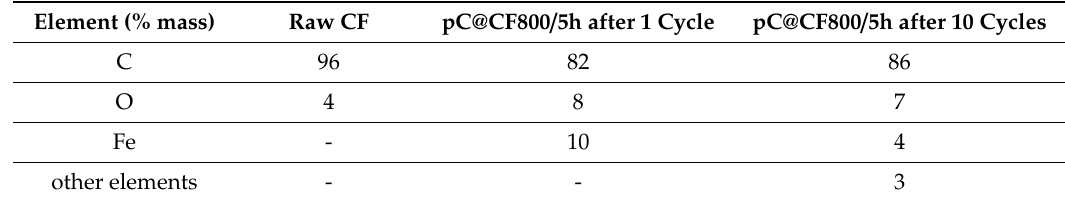
Figure 5. ( a , b ) SEM observations of pC@CF800 / 5h cathode after ten cycles heterogeneous EF process. Table 3. Elemental composition of raw CF, pC@CF800 / 5h electrode after 1 cycle and pC@CF800 / 5h electrode after 10 cycles heterogeneous EF process.